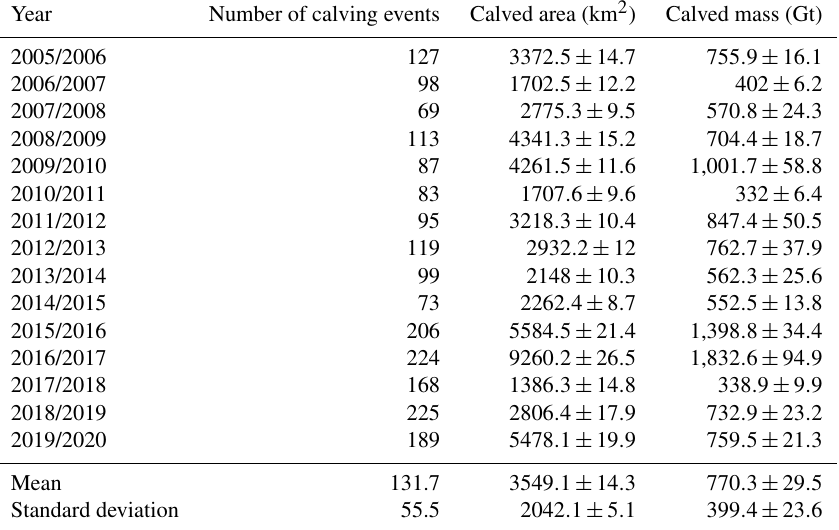
Table 5. Annual distribution of the number of calving events, calved area, and calved mass for August 2005 to August 2020.